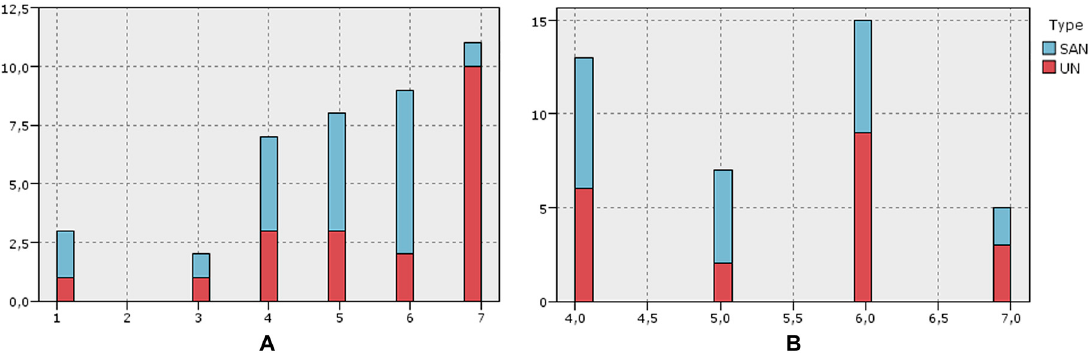
Figure 5. The partner behavior. UN = unassisted negotiation; SAN = smart assisted negotiation; A = My partner was friendly with me during the negotiation; B = My partner also made a concession if I had made a concession.